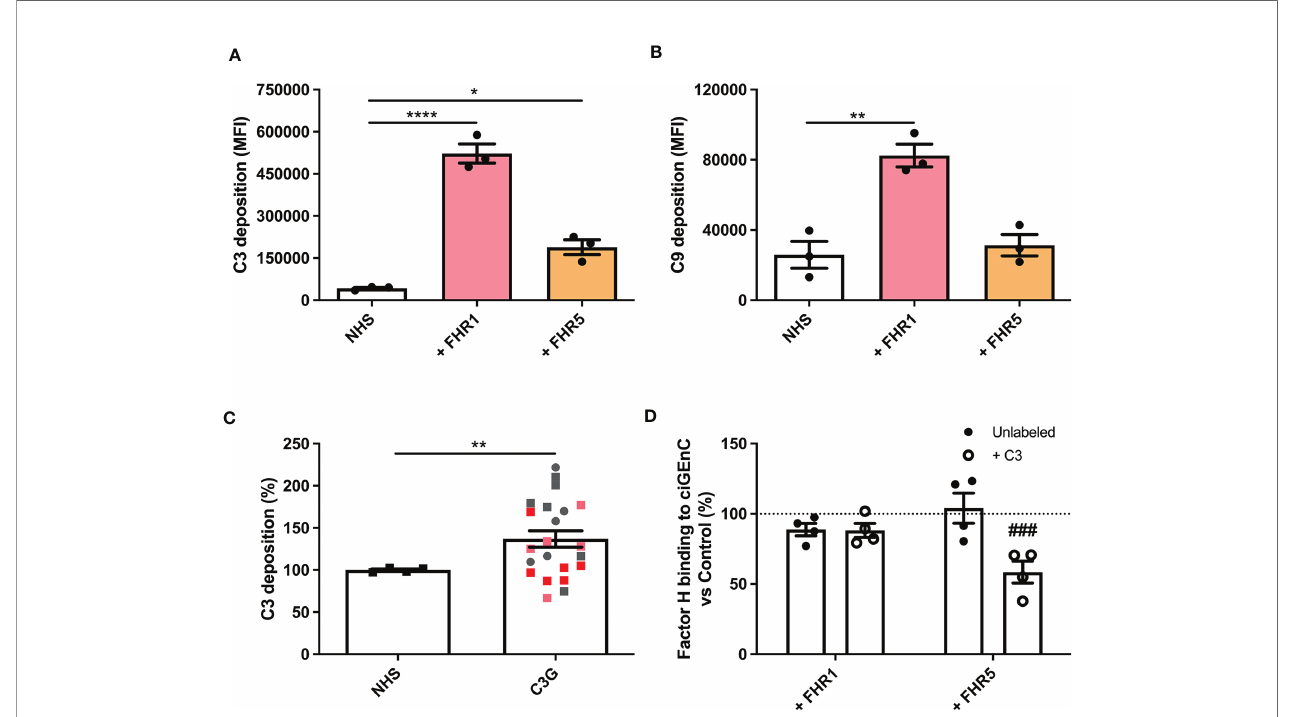
FIGURE 2 | Factor H-related proteins 1 and 5 deregulate alternative pathway activation on glomerular endothelial cells in vitro . ciGEnCs were incubated in 20% normal human serum (NHS) in veronal-buffered saline including 5 mM magnesium-EGTA, which prevents classical/lectin pathway activation. Serum was supplemented with factor H-related proteins (FHRs) 1 or 5 and effects on alternative pathway (n=3) (A) and terminal pathway (n=3) (B) activity were evaluated using fl ow cytometry. ciGEnCs were incubated with NHS or C3G patient sera (n=4, healthy controls; n=22, C3G patients) (C) , including patients: with 3 to 4 copies of the FHR1 gene (pink), FHR1 and FHR3 deletion ( D CFHR3-1) (red), 402H/H haplotype (grey square) and 402Y/Y haplotype (grey circle). Sera were supplemented with C3, factor B and factor D to ensure the presence of suf fi cient amounts of AP components. To determine the effect of FHR competition on FH binding, unlabeled or C3b-labeled ciGEnCs were pre-incubated with buffer (Control) or FHRs 1 or 5, after which FH binding was detected using ELISA (n=4) (D) . (*p < 0.05, **p < 0.01, ****p < 0.0001 vs NHS; ### p < 0.001 vs